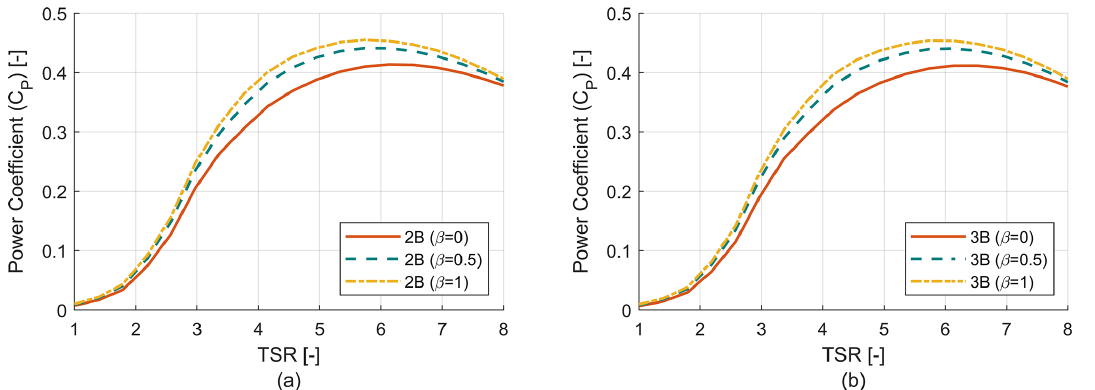
Figure 6. Rotor power coefficient ( C P ) analysis. (a) Power coefficient ( C P ) vs. TSR curve for two-bladed (2B) rotors. (b) Power coefficient ( C P ) vs. TSR curve for three-bladed (3B) rotors.